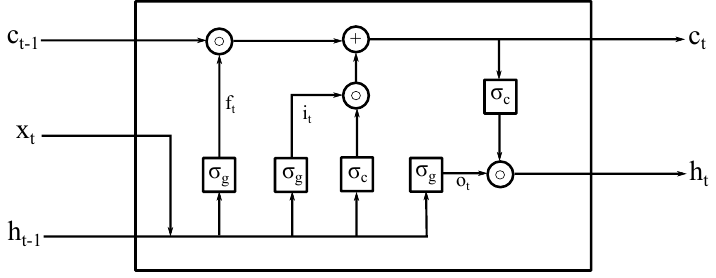
Figure 2. A schematic illustrating the internal gating operation in a single LSTM cell. The ”+” represents an additive operation and the “ ◦ ” represents a multiplicative operation. σ g is the sigmoidal activation function and σ c is the hyperbolic tangent activation